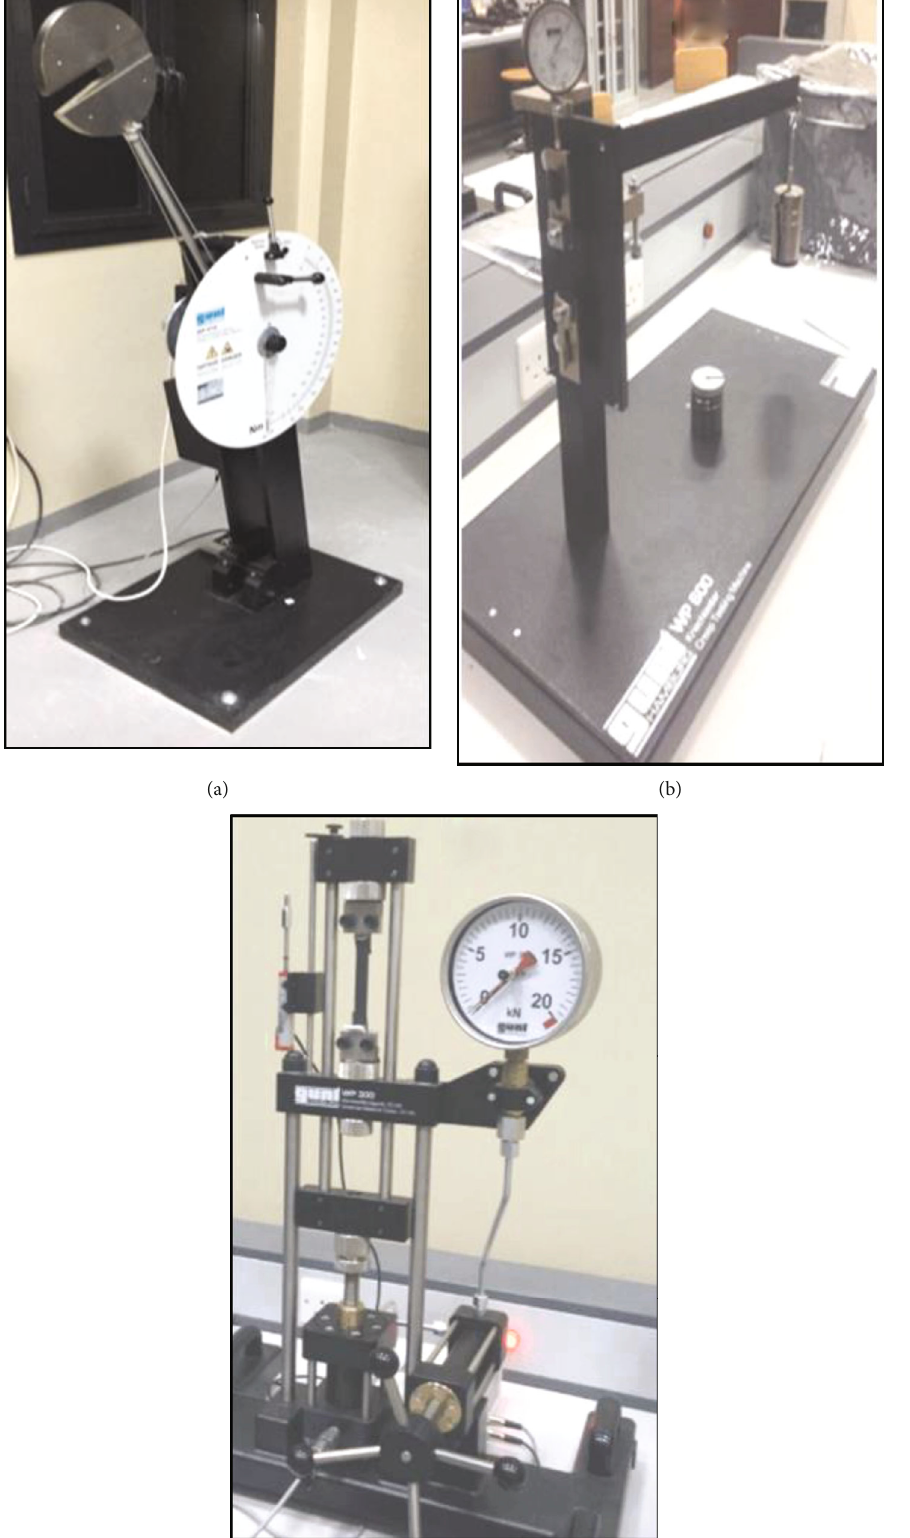
Figure 4: Machines used for testing: (a) impact GUNT WP 410 machine, (b) creep GUNT WP 600 machine, and (c) tensile GUNT WP 300